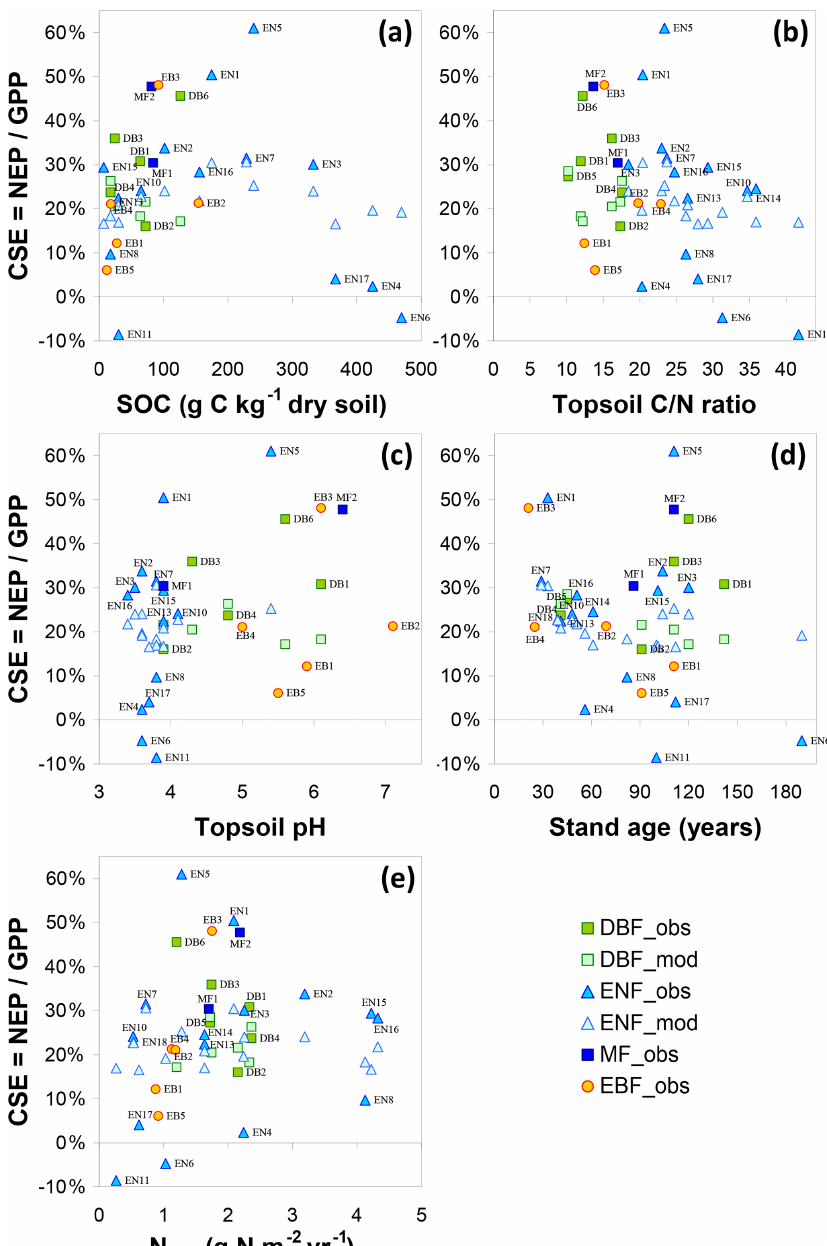
Figure 10. Variability of observation-based (obs) and modelled (mod) carbon sequestration efficiency (CSE) defined as the ratio of net ecosystem productivity (NEP) to gross primary productivity (GPP), calculated over a ∼ 5-year measurement period. The data are plotted versus (a) topsoil organic carbon content (SOC), (b) topsoil C / N ratio, (c) topsoil pH, (d) forest stand age and (e) nitrogen deposition ( N dep ). DBF: deciduous broadleaf forests; ENF: coniferous evergreen needleleaf forests; MF: mixed needleleaf–broadleaf forests; EBF: Mediterranean evergreen broadleaf